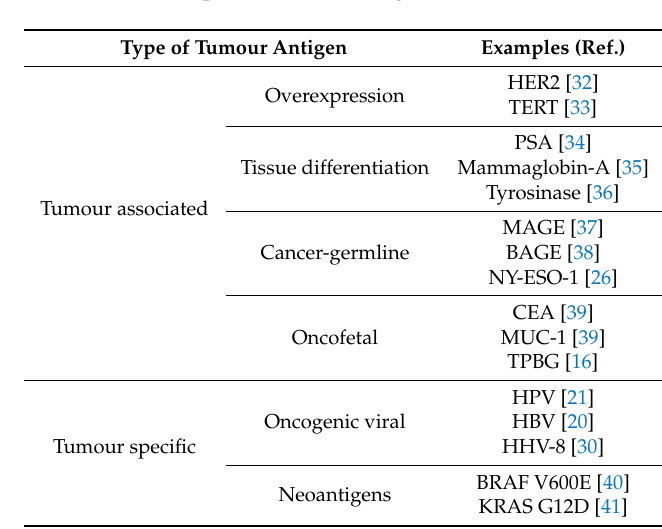
Table 1 HER human epidermal growth factor receptor, TERT telomerase reverse transcriptase, PSA